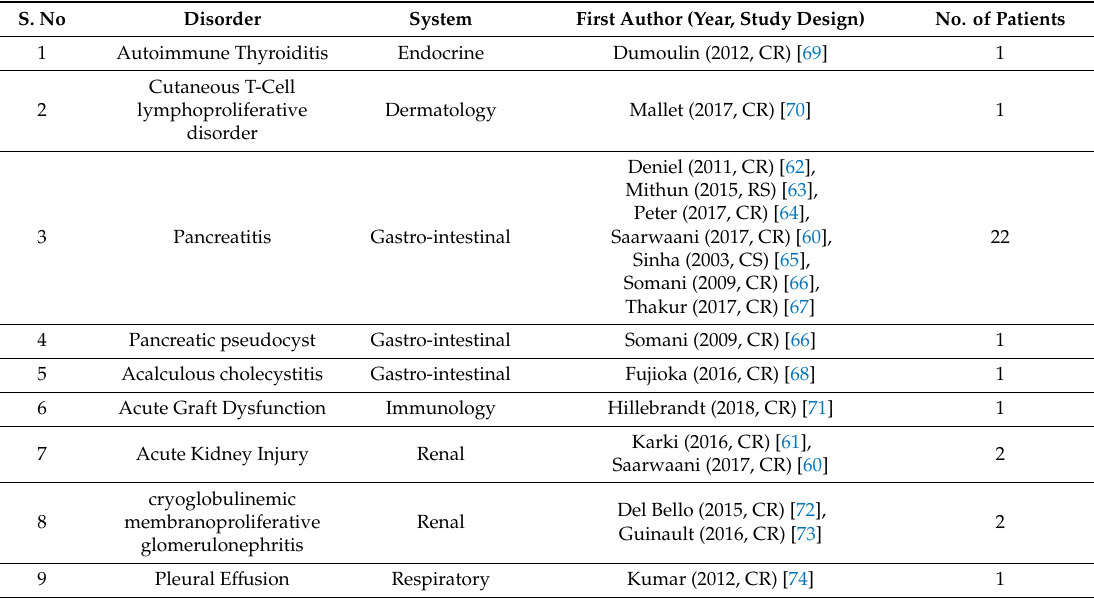
Table 3. Miscellaneous extra-hepatic manifestations of hepatitis E